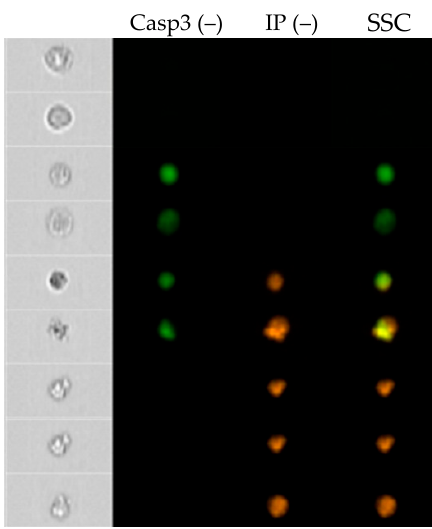
Figure 4. An exemplary cytometric visualization of HL60 cell lines exposed to byakangelicin in an IC50 dose in a real-time FlowSight instrument.